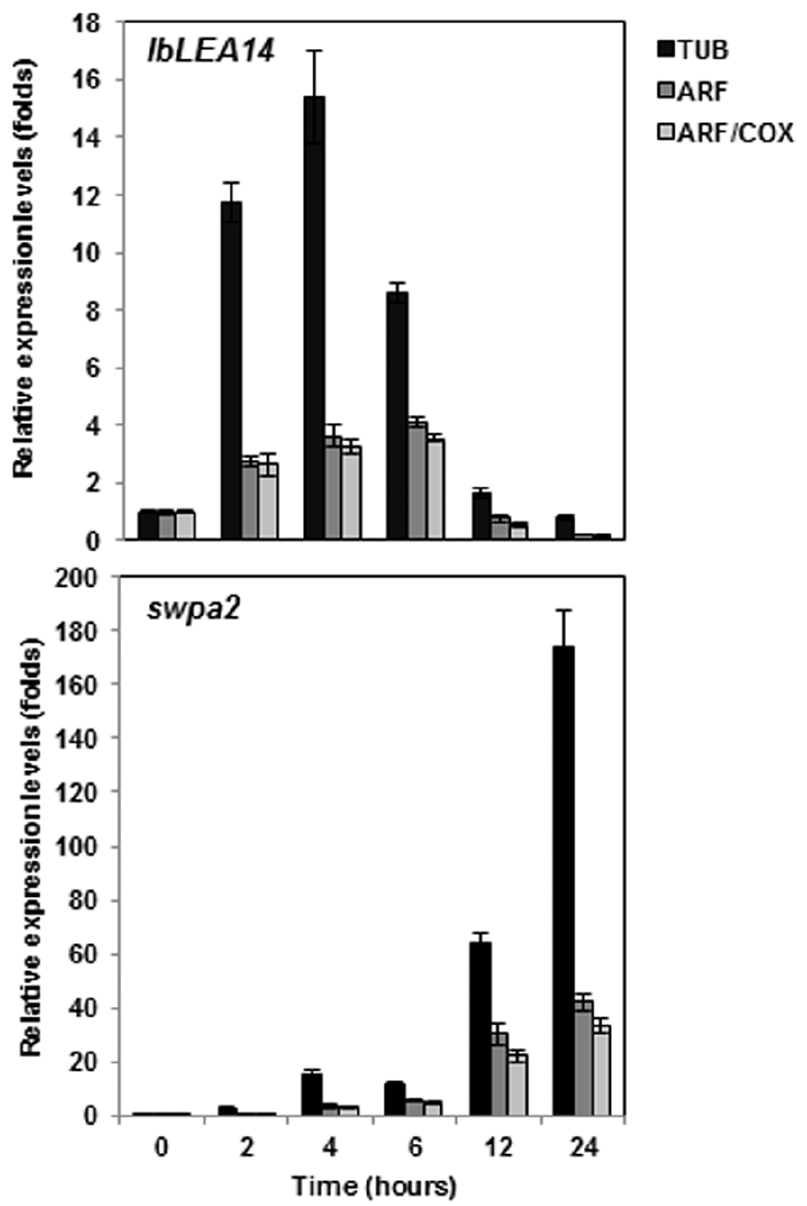
Figure 4. Relative quantification of IbLEA14 and swpa2 expression using validated reference genes for normalization under oxidative stress in the White star cultivar. (A) IbLEA14 and (B)